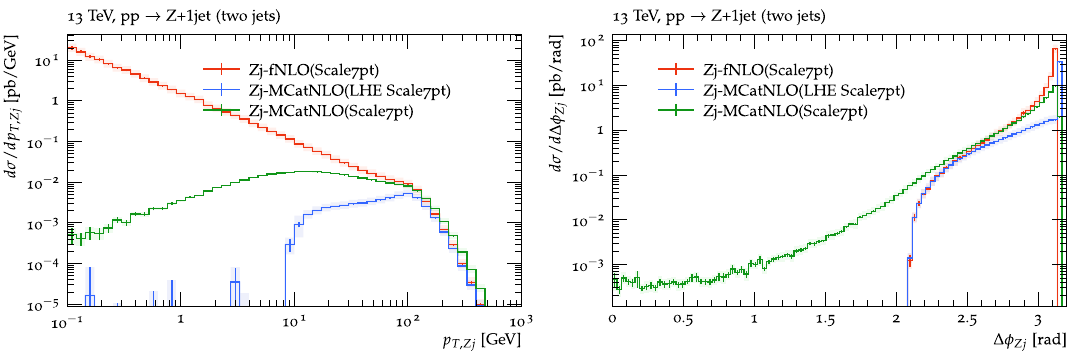
Fig. 2 Transverse momentum spectrum of the Z + jet-system p T , Zj (left) and (cid:2)φ Zj distribution (right). Shown are predictions from fixed NLO (fNLO), the (unphysical) distribution at LHE-level and the full simulation (after inclusion of PB-TMDs and TMD showers,